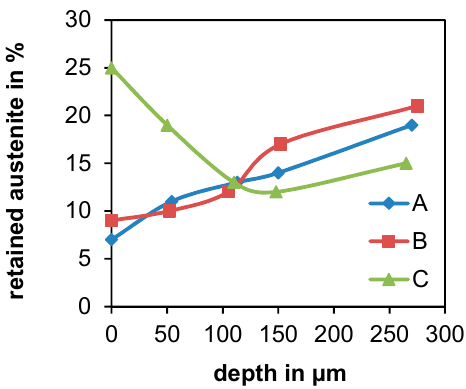
Figure 5. Retained austenite in the nitrogen-rich surface layers (for heat treatment parameters of A, B and C see Table 2).